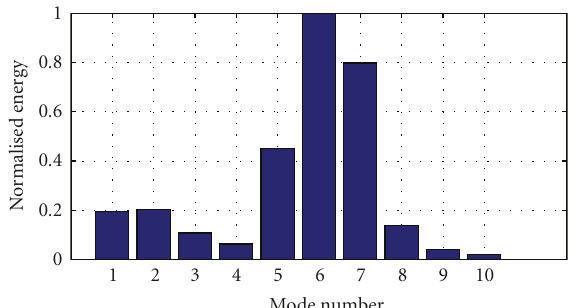
Figure 10: Energy spectrum in modal space (for modes no. 1 to 10).